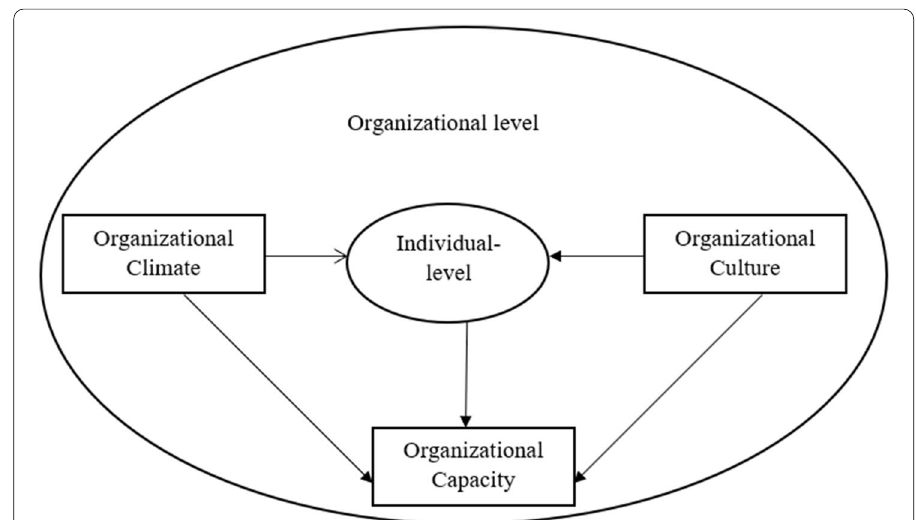
Fig. 4 The framework of organizational development theory